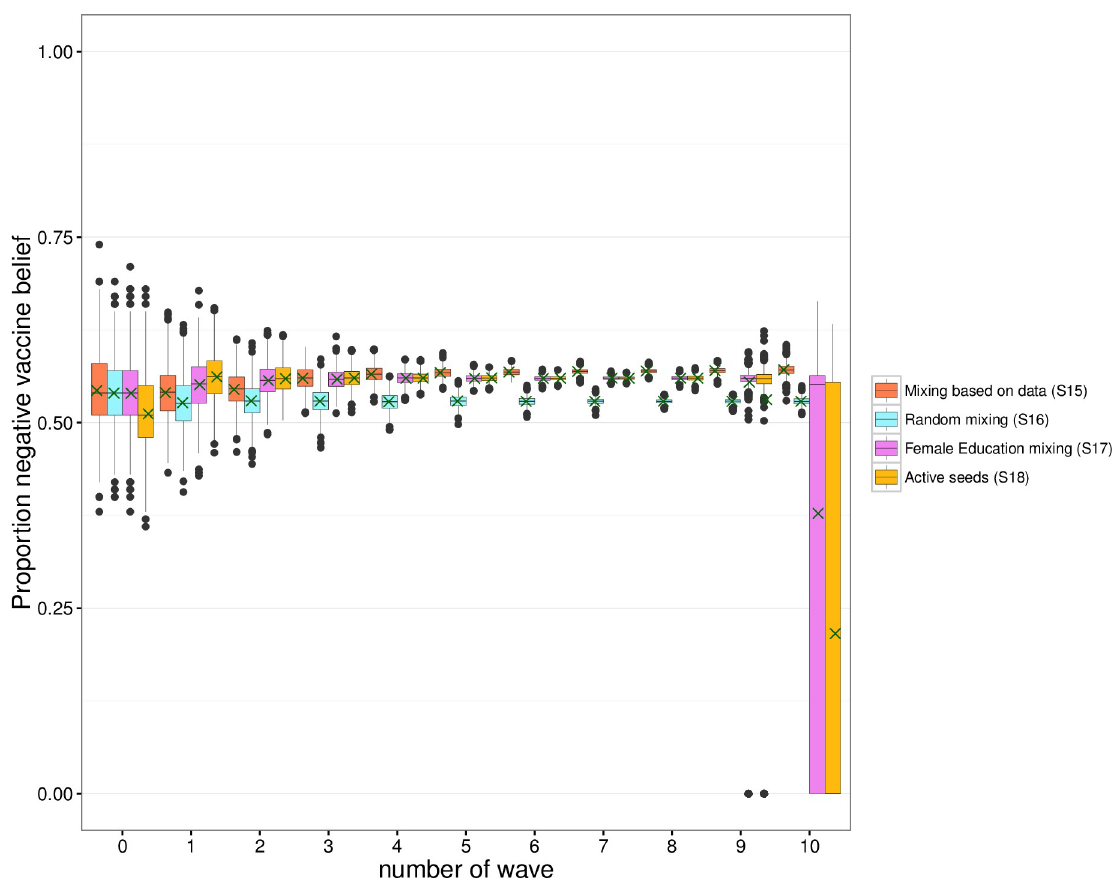
Fig 5. Composition per wave for negative vaccine beliefs. We ran simulations starting with 100 seeds with characteristics randomly drawn from the observed data (scenarios S15 to S17) and 100 active seeds (scenario S18), 1000 runs per seed. The boxplots show the variability between runs. The legend refers to scenarios S15 to S18 described in Table 3. A green cross indicates, for each wave, the mean proportion over all simulated data